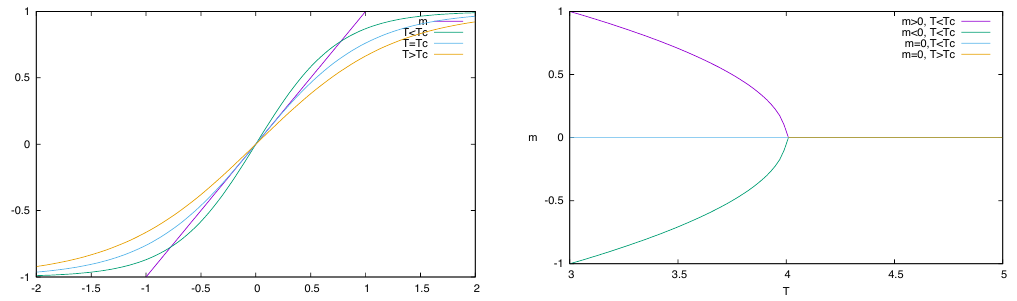
Figure 3. The bifurcation scenario of Equation (7) by varying T : ( Left ) the asymptotic values of m ( ∞ ) are given by the intersection of f = m with f = tanh ( Jkm / T ) in the left plot; and ( Right ) location of m ( ∞ ) as a function of T .